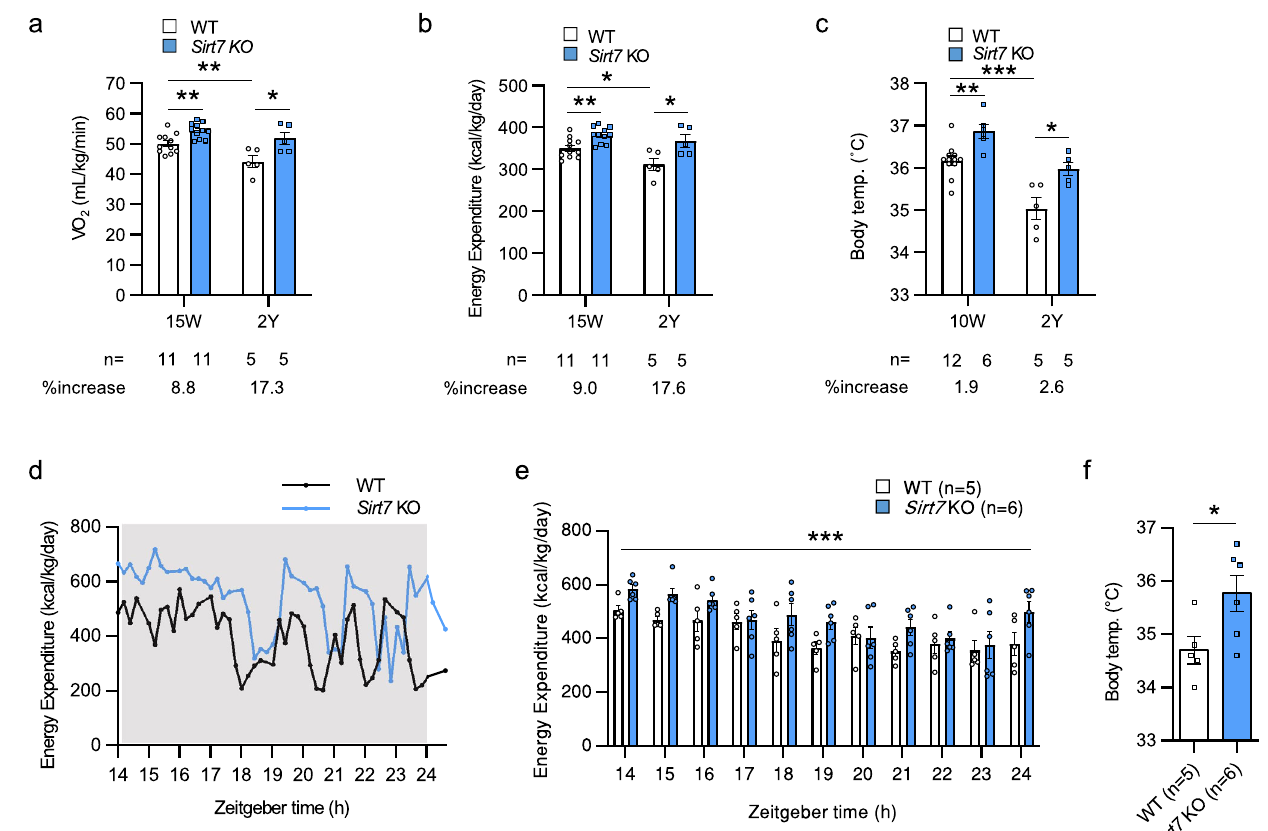
Fig. 2 | Sirt7 KOmice exhibit excessive energy expenditure and thermogenesis in the hypometabolic state. a – c Data of indirect calorimetry experiments and body temperature from 2-year-old male WT and Sirt7 KO mice (n=5 independent animals per group). Data from young mice (from Fig. 1d, f, l) are shown for a comparisonoftheirelevatedratewiththatofthe2-year-oldmice.AverageVO 2 ( a ), energy expenditure ( b ), and body temperature at zeitgeber time (ZT) 10 ( c ). p =0.0021 (15 weeks), p =0.0260 (2 years), p =0.0087 (WT 15 weeks vs. 2 years) in ( a ); p =0.0026(15weeks), p =0.0283(2years), p =0.0170(WT15weeksvs.2years) in ( b ); p =0.0025 (15 weeks), p =0.0143 (2 years), p =0.0002 (WT 15 weeks vs.